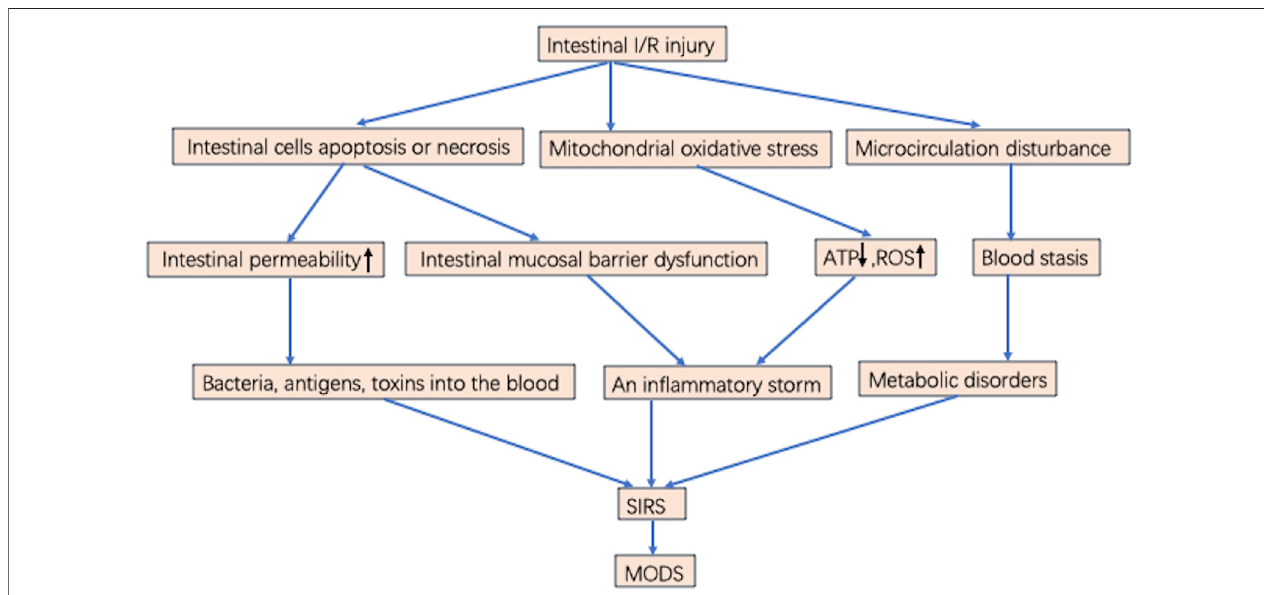
FIGURE 1 | Possible mechanisms of MODS induced by intestinal I/R injury. Intestinal I/R injury results in intestinal cells apoptosis or necrosis, mitochondrial oxidative stress, and microcirculation disturbance. microcirculation disturbance induces blood stasis and metabolic disorders. Increasing ROS, cytokines, chemokines, and in fl ammatory mediators lead to an in fl ammatory storm. Intestinal mucosal barrier dysfunction and increased permeability result in numerous bacteria or toxins through the blood into the circulatory system, leading to SIRS. When the treatment is inappropriate or not timely, it eventually develops into